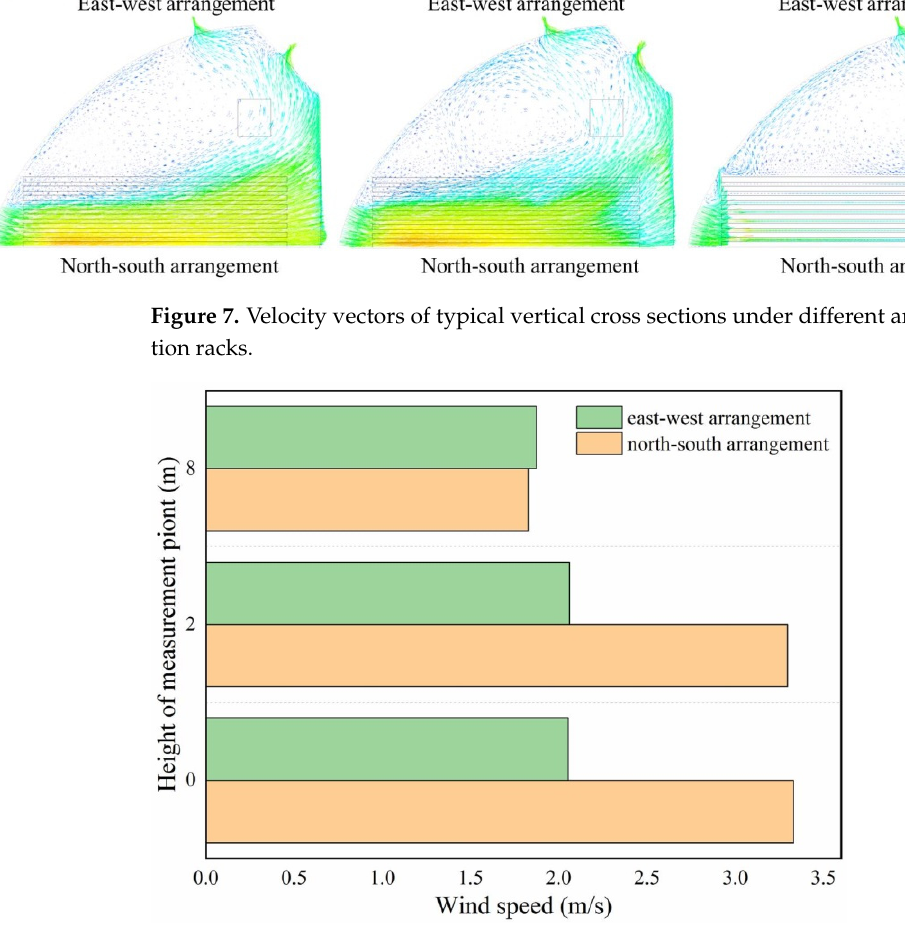
Figure 8. Velocity magnitudes of typical vertical cross sections under different arrangements of cultivation racks. cultivation